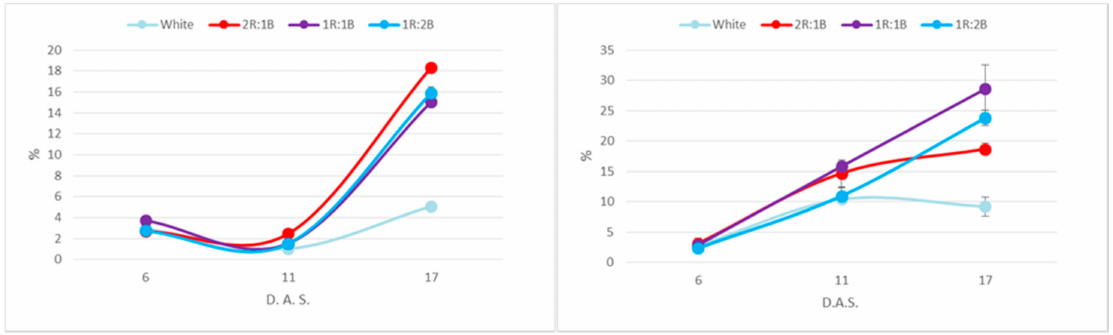
Figure 6. Free radical scavenging capacity of: green basil cultivar ( Left ); and red basil cultivar ( Right ). Anthocyanin contents were higher for all treatments compared to white light, however 2R:1B had the highest accumulation (Table 3). For individual phenolic acids of the red cultivar, the light treatments induced effects consistent with those seen for total phenolics and flavonoids. Both caffeic and rosmarinic acid synthesis was stimulated most by the 1R:2B treatment, followed by the 1R:1B, 2R:1B and white light treatments (Table 4). The increase by 1R:2B light in rosmarinic acid was 15-fold compared to white light, while the increase in caffeic acid was four-fold. Table 3. Selected phenolic acids and anthocyanins contents of red basil cultivar. Treatment White 2R:1B 1R:1B 1R:2B Caffeic acid (mg/g f.w.) Rosmarinic acid (mg/g f.w.) Anthocyanins (mg/g f.w.)